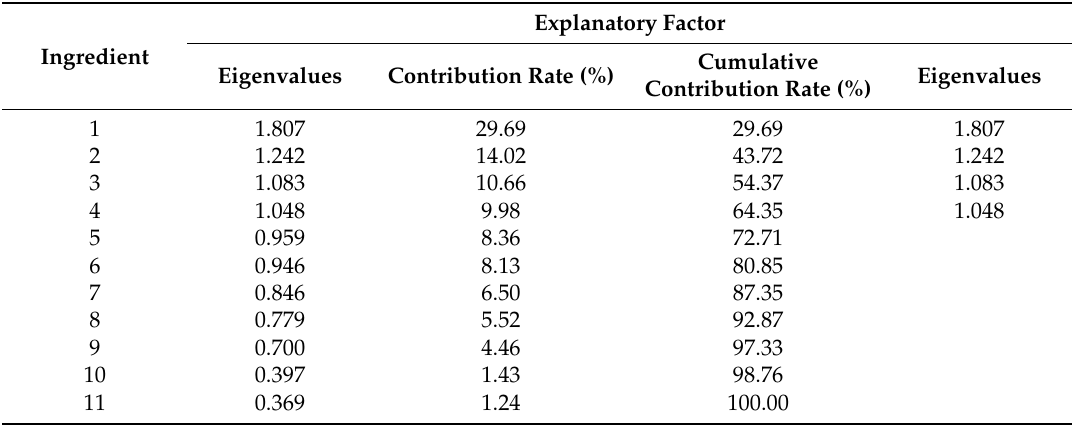
Table 4. Principal component variance contribution